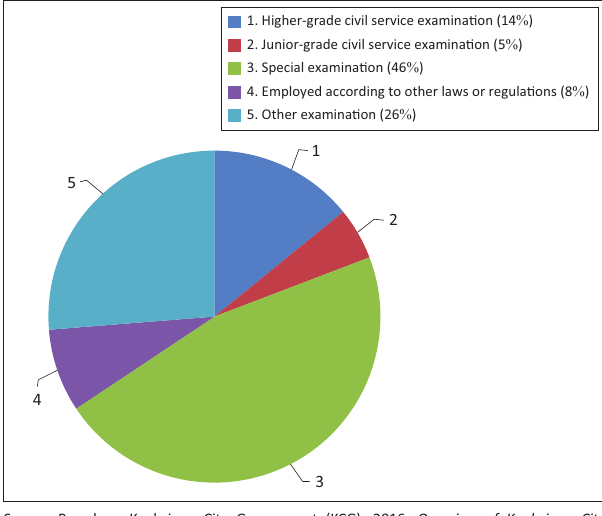
FIGURE 2: Kinds of examinations passed by the staff of different departments of Kaohsiung City Government in